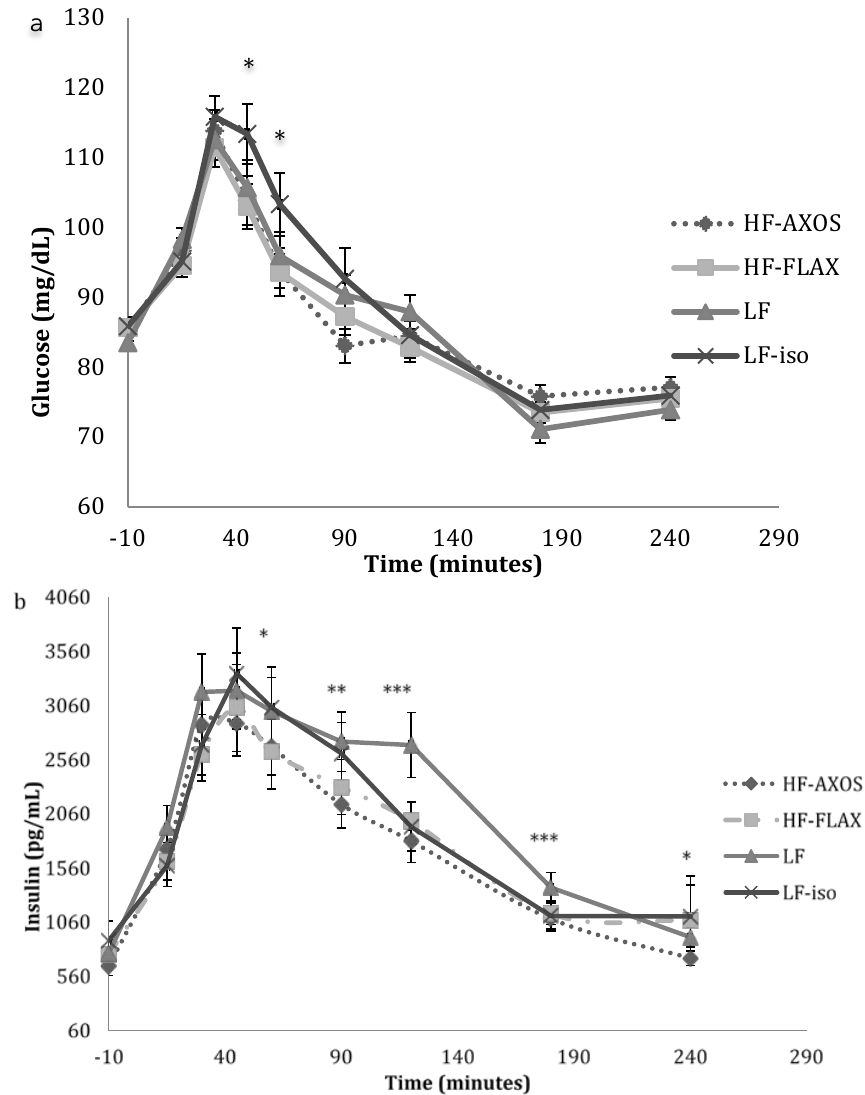
Figure 3. Plasma glucose and insulin concentrations at selected time points: ( a ) glucose, ( b ) insulin. Significant differences among groups are signified as follows: *** p < 0.001; ** p < 0.01; * p < 0.05. LF: low-fiber RTEC; HF-AXOS: high-fiber (HF) RTEC with